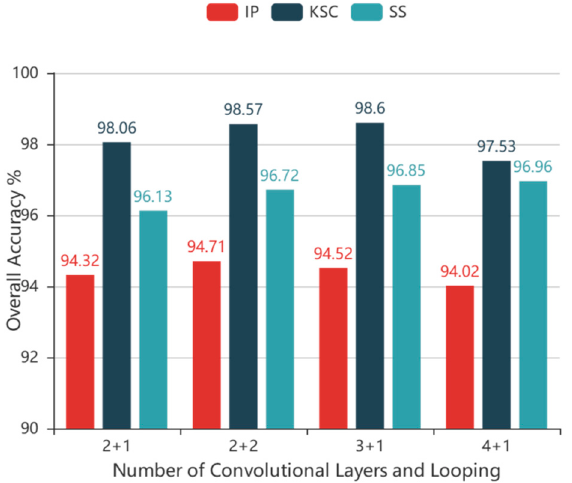
Figure 6. The overall accuracy of the AUSSC with different numbers of convolutional layers and loops in each block. The 𝑎 + 𝑏 notation on the x -axis denotes the AUSSC with 𝑎 convolutional layers and 𝑏 looping iterations in stage 2 of each block. IP: Indiana Pines data set; KSC: Kennedy Space Center data set; SS: Salinas Scene data set.